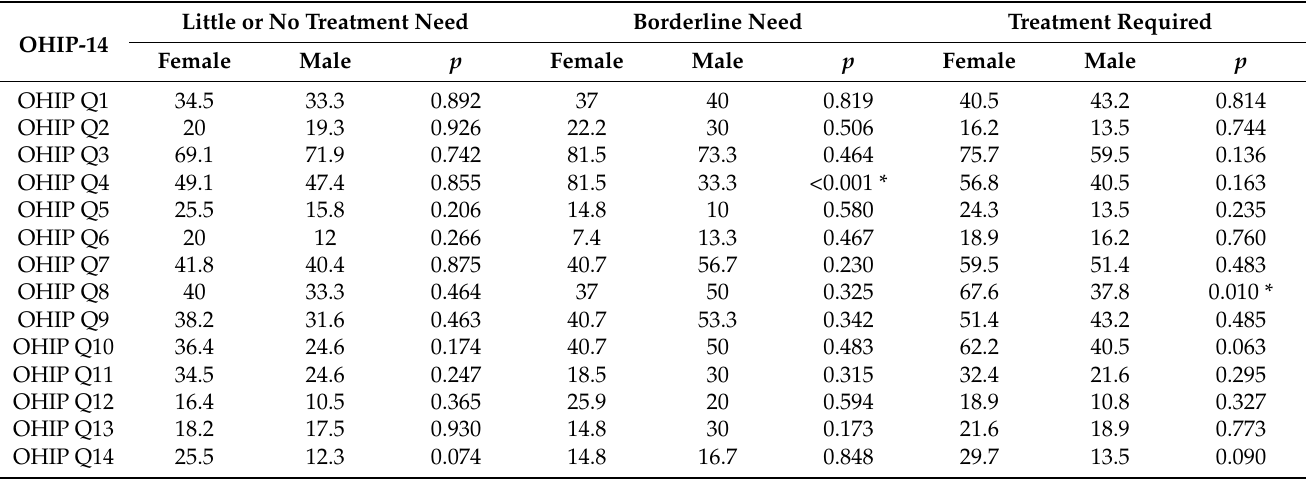
Table 6. Frequency of impact (in %) of each item of the OHIP-14 on IOTN-DHC in relation to the gender of the study participants (N = 243).